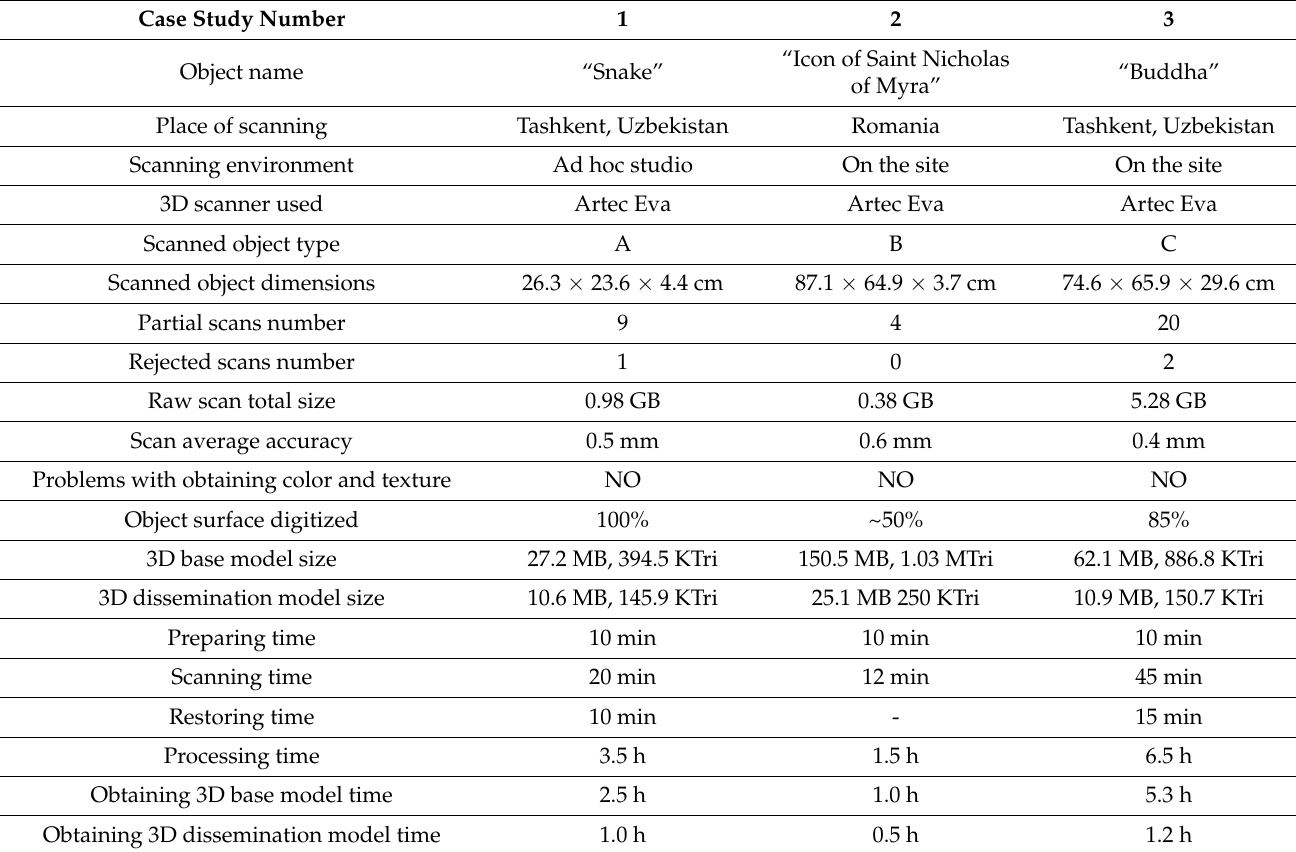
Table 2. Results of 3D scanning for the case